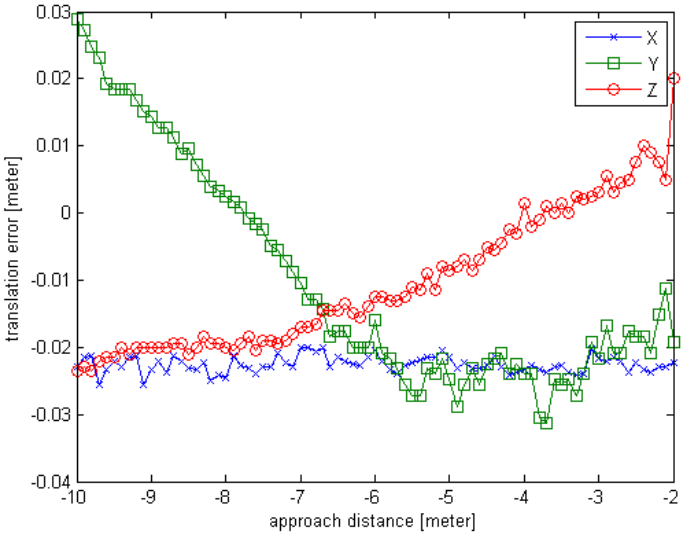
Figure 11. The translation error curve of Experiment 3 for relative motion.